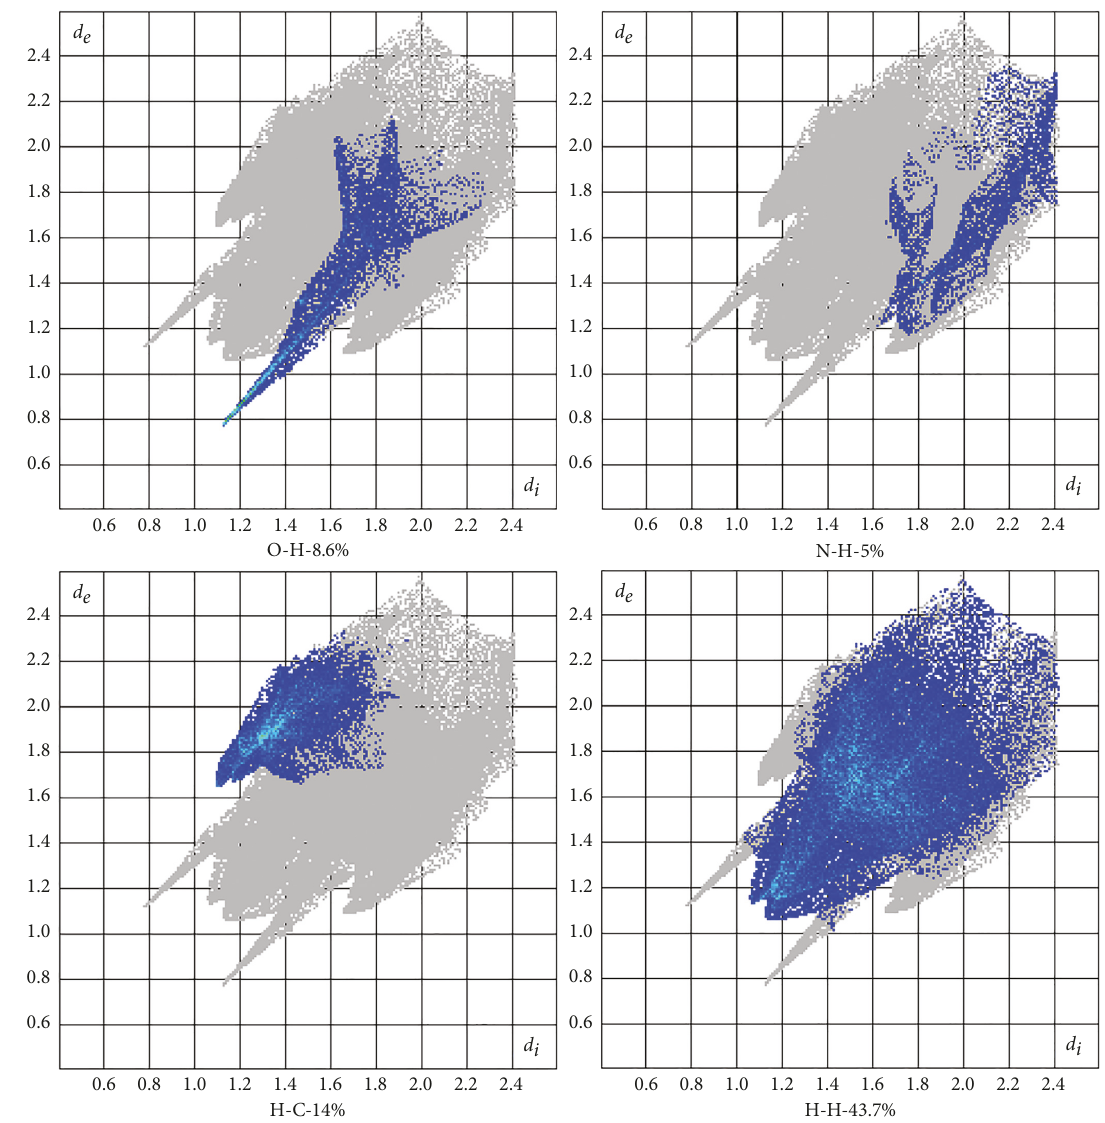
Figure 7: Fingerprint plots of BDSC O–H 8.6%; N–H 5%; H–C 14%; H–H